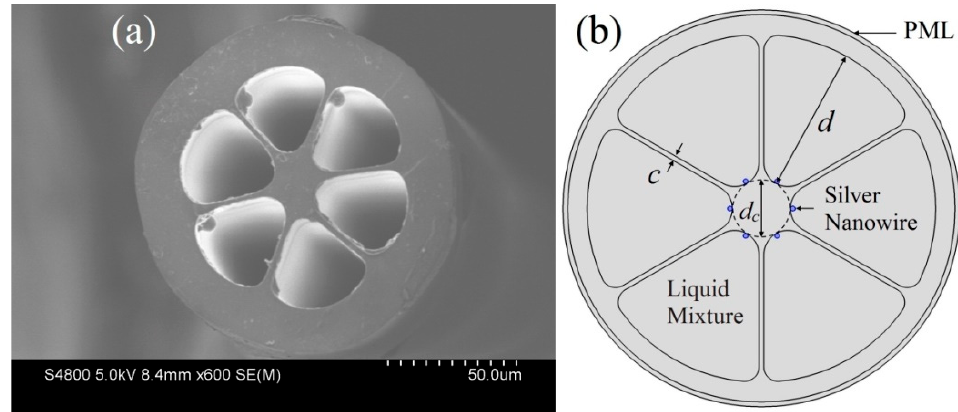
Figure 4. ( a ) Cross-section of the six-hole PCF; ( b ) schematic of the proposed sensing device coated with silver nano wires and filled with the mixture of ethanol and chloroform [62].